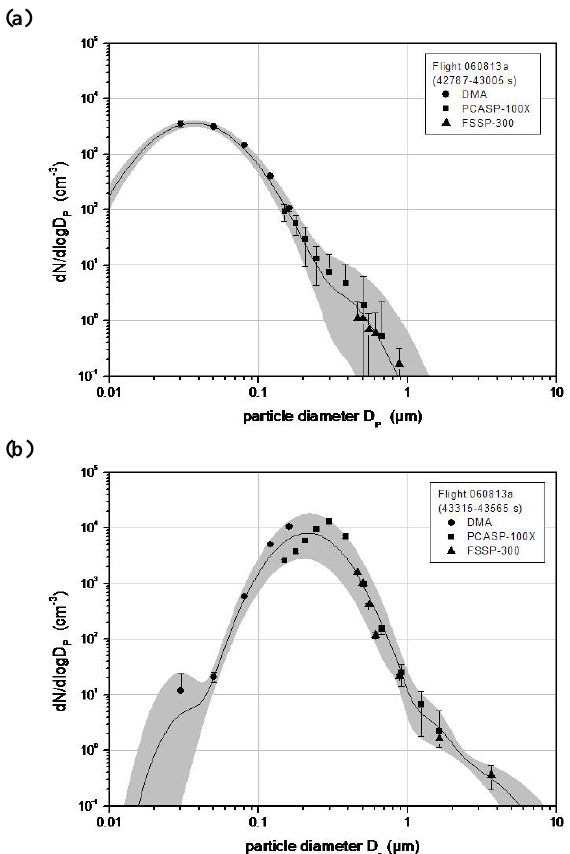
Fig. 7. Aerosol particle size distributions measured (a) above the MT-plume at 4500m (528 hPa), and (b) in the MT-plume at 3900m (645 hPa) altitude. Different symbols represent data points of dif- ferent instruments (see legend). The line as well as the lower and upper end of the grey shaded area represent log-normal fits to the data (averaged, minimum, maximum concentrations within the in- tegration time